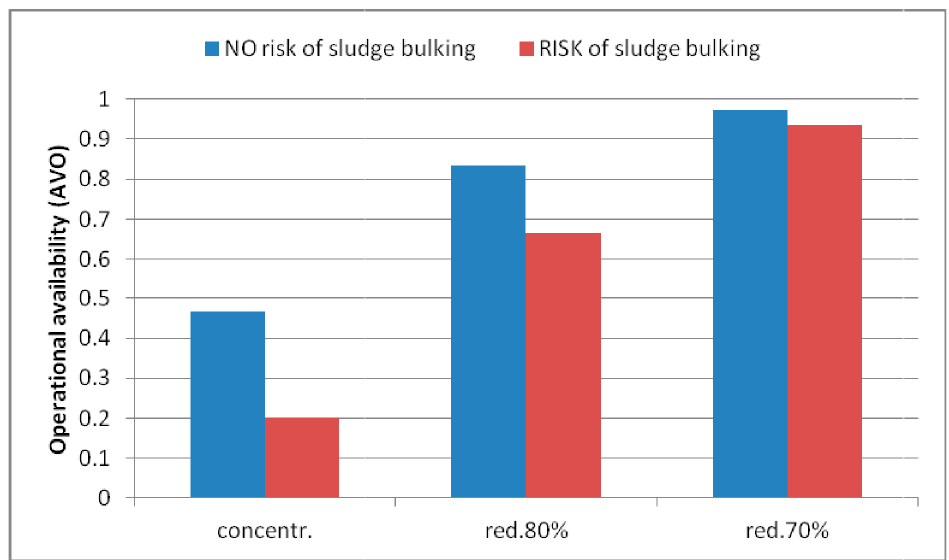
Figure 2. Operational availability of modelled plant–Scenario 1 (S1), in terms of total nitrogen removal, for different possible constraints (concentration < 10 g/m 3 , reduction of at least 80%, reduction of at least 70%).